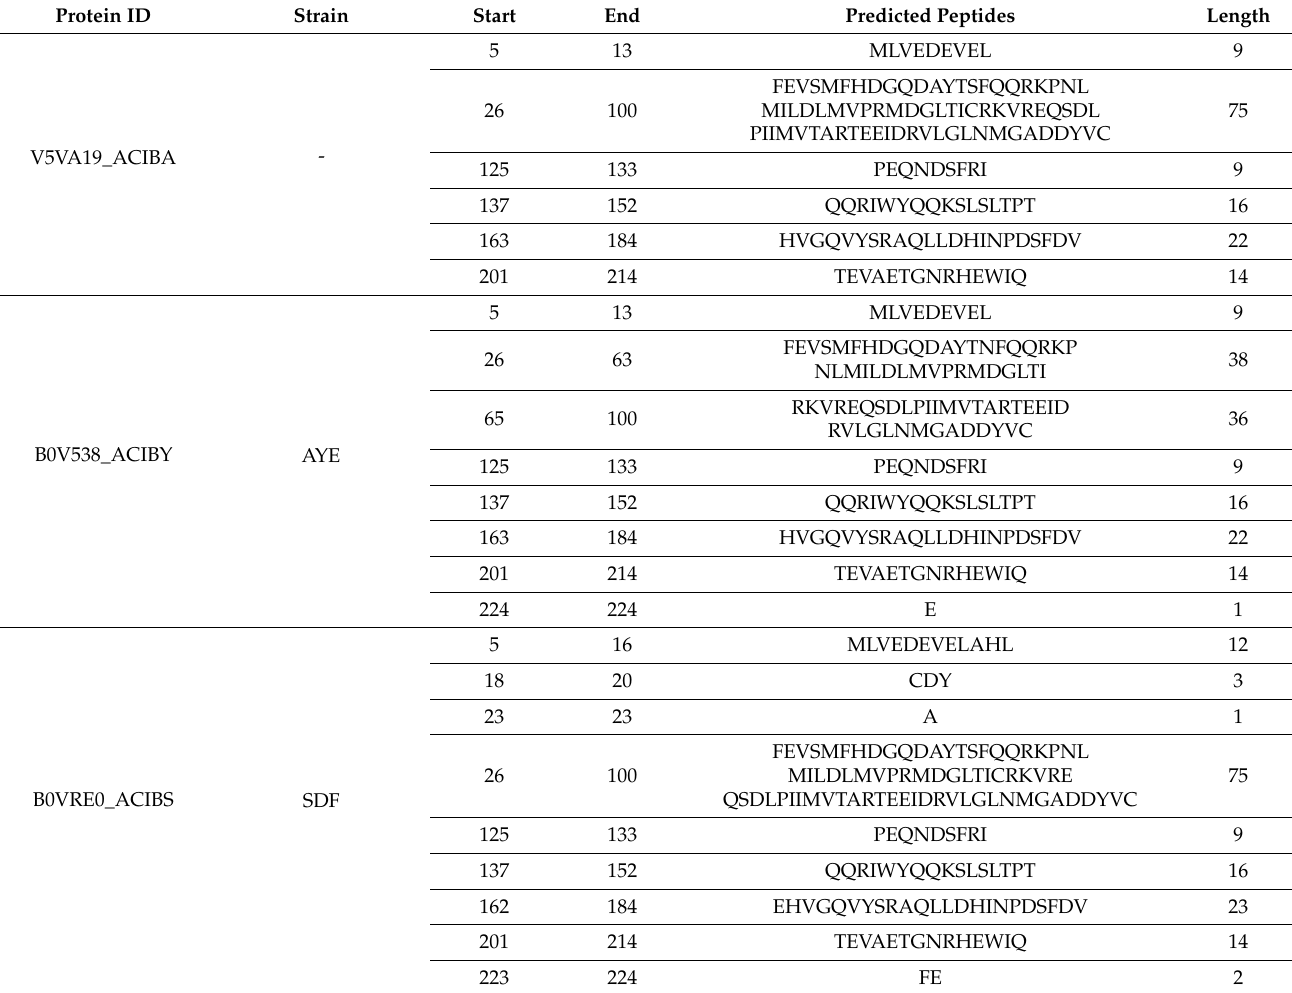
Table 1. Predictions of B-cell linear epitopes from BaeR of A. baumannii . Protein ID Strain Predicted